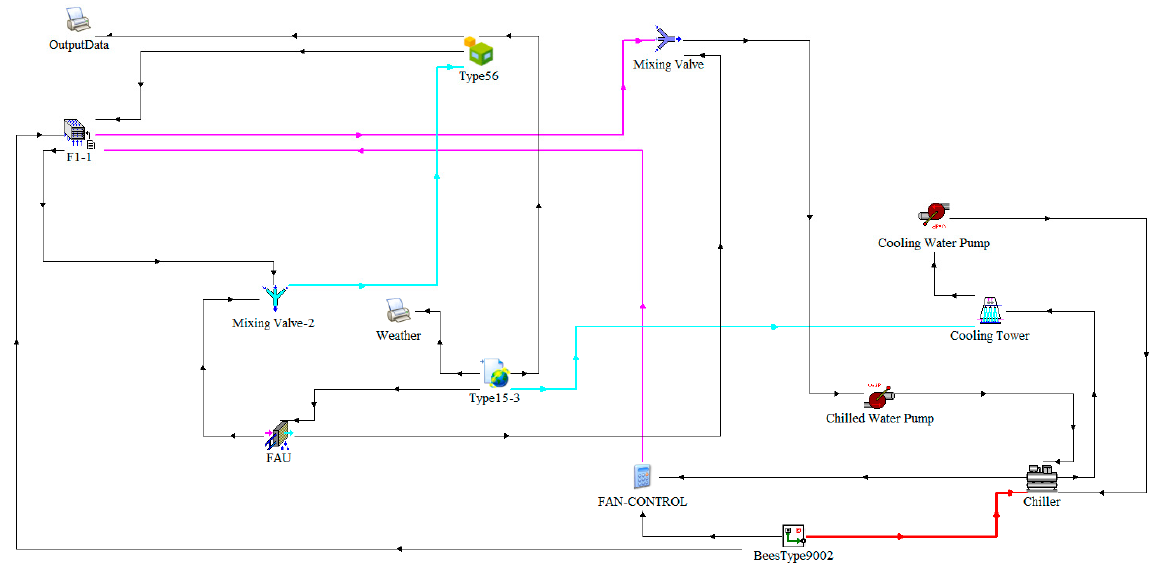
Figure 6. Schematic diagram of the HVAC system operation.